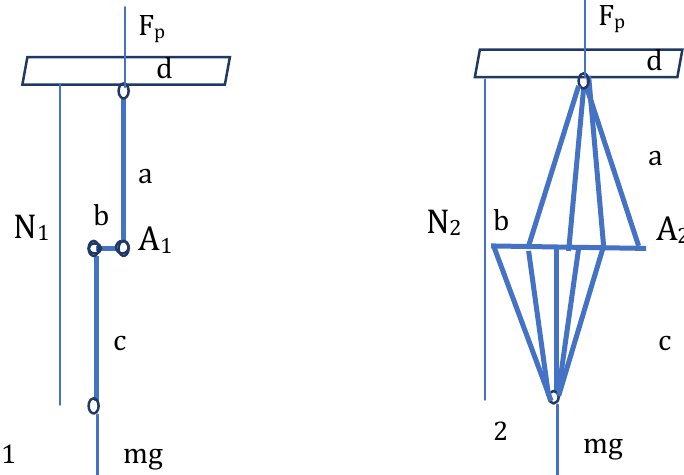
Fig. 2. Diagrams of models of stress distribution when hanging in rock climbing (bouldering): 1 - model 1 (wrong technique, typical for novice athletes); 2 - model 2 (correct technique, typical for qualified athletes); a - the upper part of the chain (upper limb); b - connection of the upper and lower parts of the chain; c - the lower part of the chain (trunk); d - support (climbing stand); N is the longitudinal force in the cross section of the rod; A - cross-sectional area of the rod (muscles and ligaments at the junction of the shoulder and trunk)